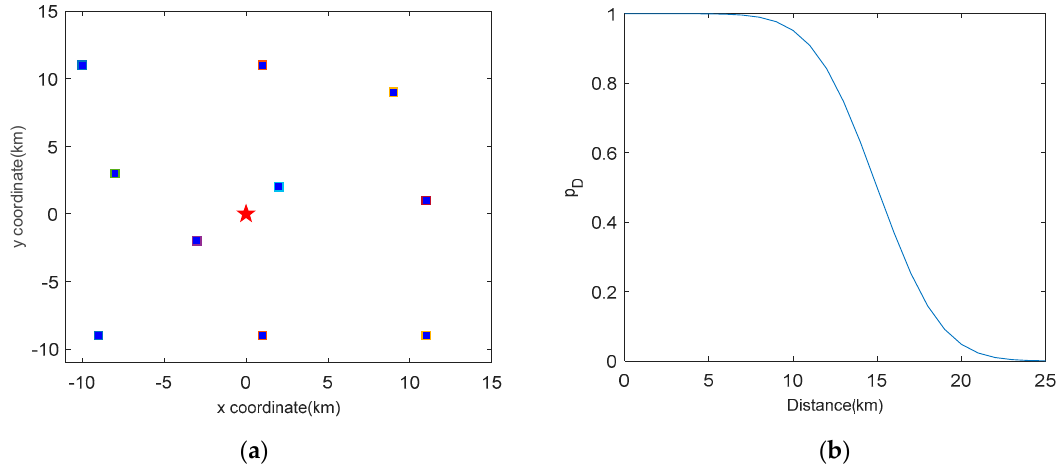
Figure 2. System setup: ( a ) The locations of receivers (squares) and the transmitter (star); ( b ) Probability of detection as a function of the distance from a receiver.